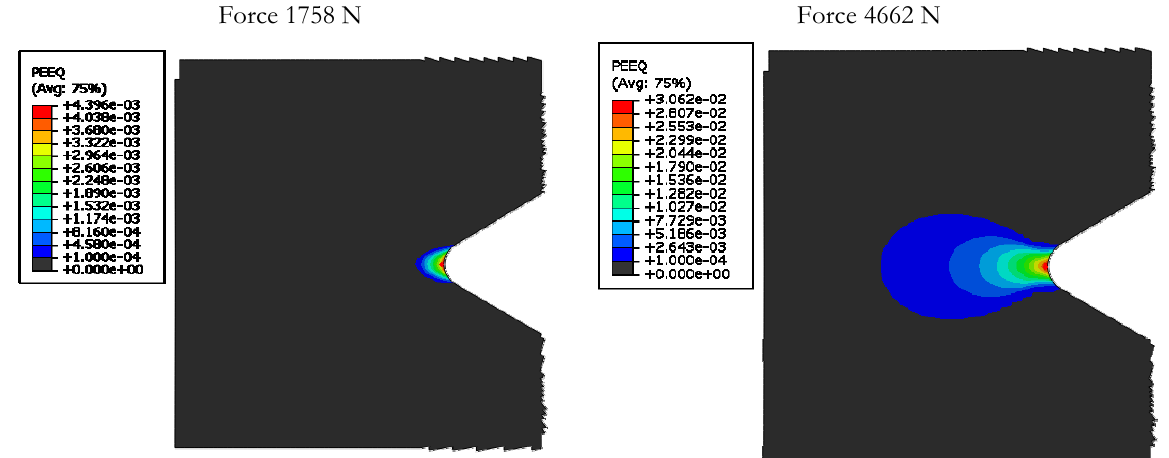
Figure 5: Plastic zone evaluated by FEM for the same specimen and same load levels